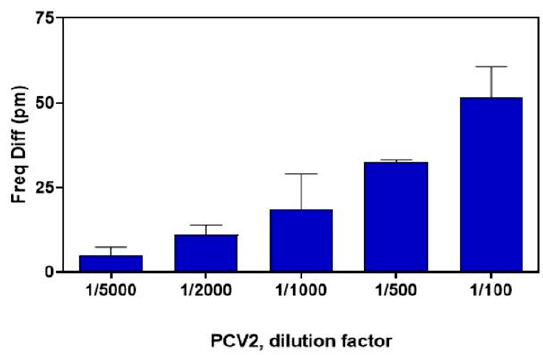
Figure 8. Response against PCV2 virus at different dilution factors (from 1/100 to 1/5000 in PBS buffer).